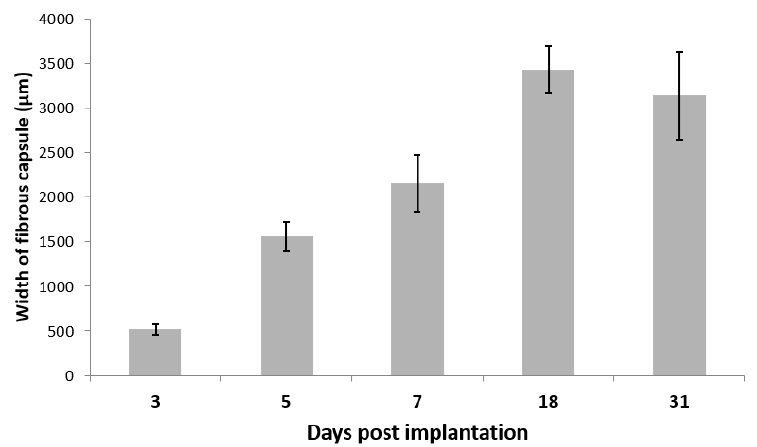
Figure 6. The size of the connective tissue capsule around the implant Error bars were calculated using the standard deviation ( n = 6).